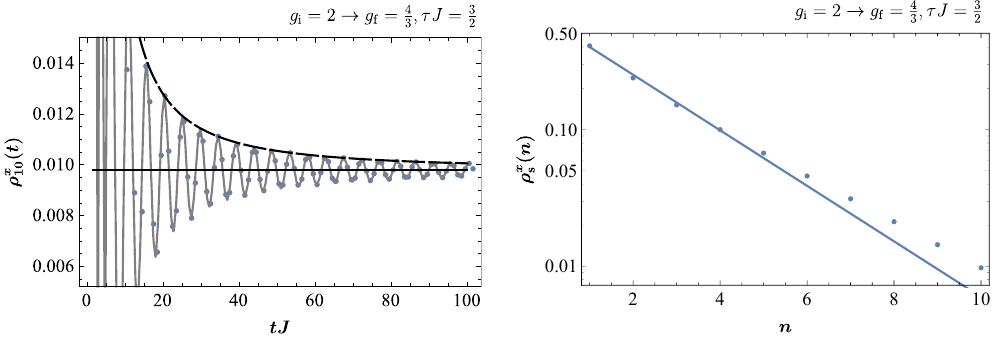
Figure 9: Left: Two-point correlation function in the longitudinal direction following a linear quench. The full line is the stationary phase approximation result, the dashed line its t − 3 / 2 envelope. Right: Stationary value of the two-point function for varying spin separations. The full line is an exponential fit to the